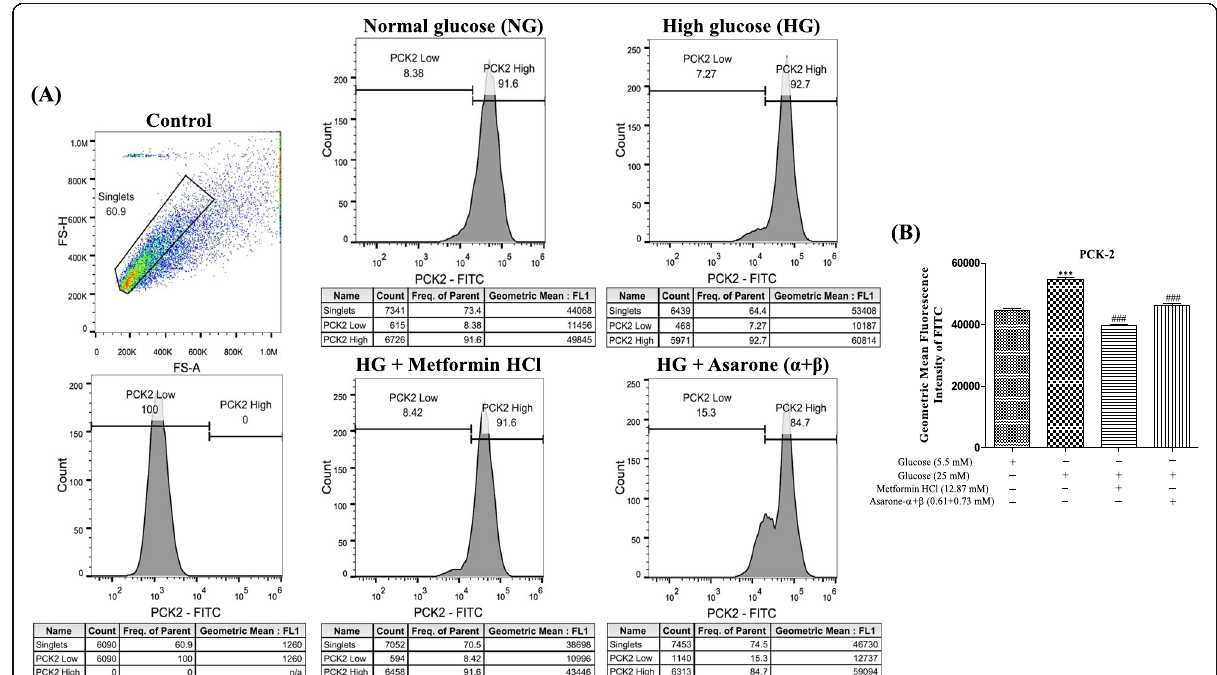
Fig. 4 The treatment of high glucose-promoted HepG2 cells with metformin and asarone downregulates the expression of PCK-2. a A representative flow cytometry histogram events depicting the expression of PCK-2 in normal glucose (NG; 5.5 mM), high glucose (HG; 25 mM), HG + Metformin HCl, and HG + Asarone. b Bar diagrams represent geometric mean fluorescence intensity (GMFI) of PCK-2 in HepG2 cells. Values represent mean ± SEM of an experiment done in triplicate; one-way ANOVA followed by Bonferroni test, where *** p < 0.001 compared to the normal glucose (NG) group and ### p < 0.001 compared to the high glucose (HG)